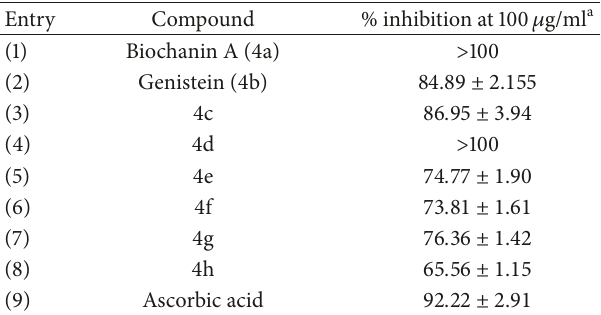
Table 1: DPPH radical scavenging activity of the target